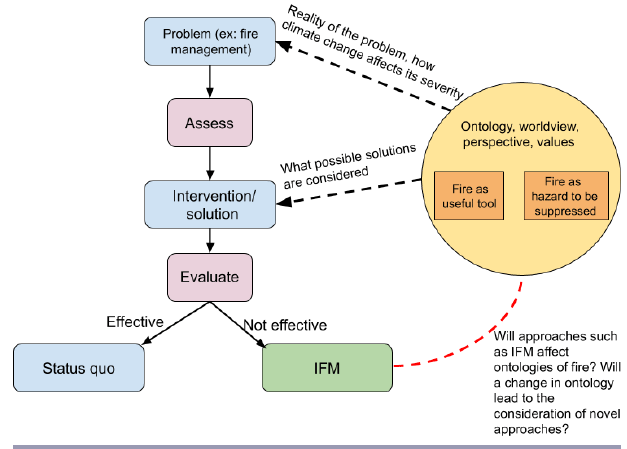
Fig. 1 . Indigenous fire management (IFM) within environmental decision making. This dynamic framework shows environmental decision-making processes for a given environmental problem (in this case, wildfire). The dashed lines represent potential effects of ontologies on the decision-making process over